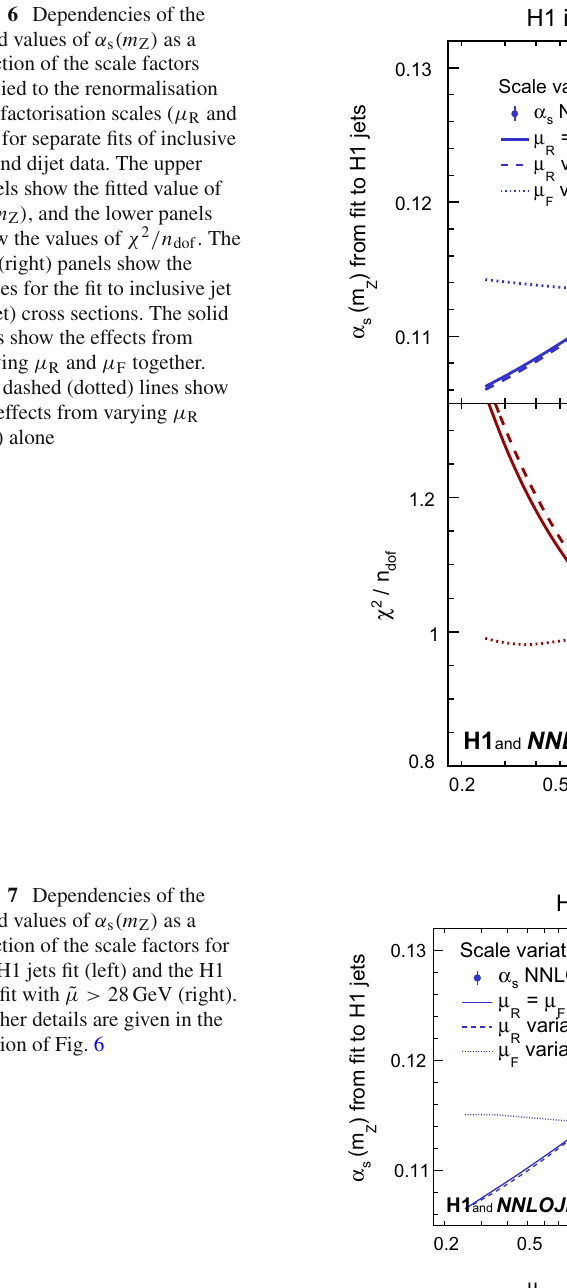
Fig. 7 Dependencies of the fitted values of α s ( m Z ) as a function of the scale factors for the H1 jets fit (left) and the H1 jets fit with ˜ μ > 28GeV